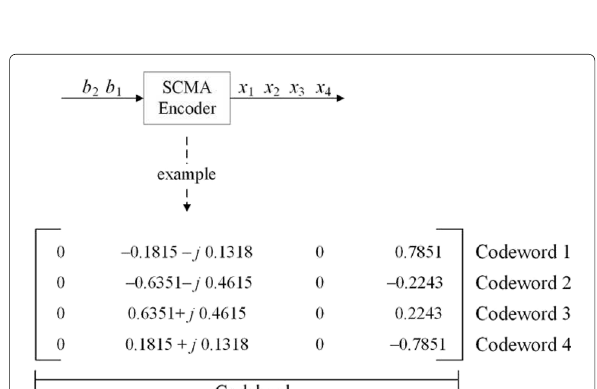
Fig. 1 Codebook of an SCMA